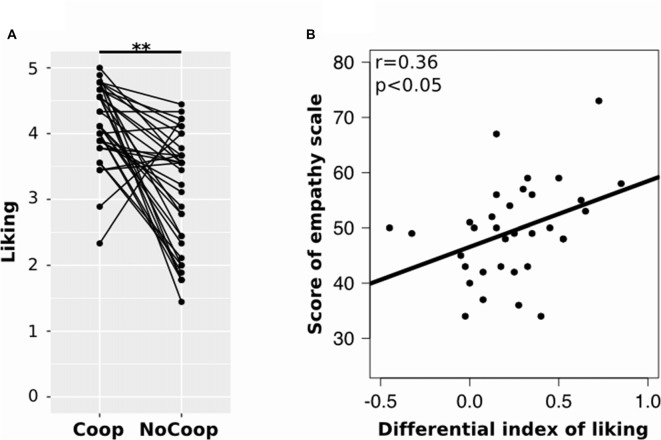
Results of the post-scan scales. (A) Post-scan ratings of participants in scale of liking for each confederate: cooperative (Coop) and non-cooperative (NoCoop). Bars represent the mean and the error bars show the standard error. (B) Correlation of scores of empathy scale, EQ, with differential index of linking scale. **p < 0.01.